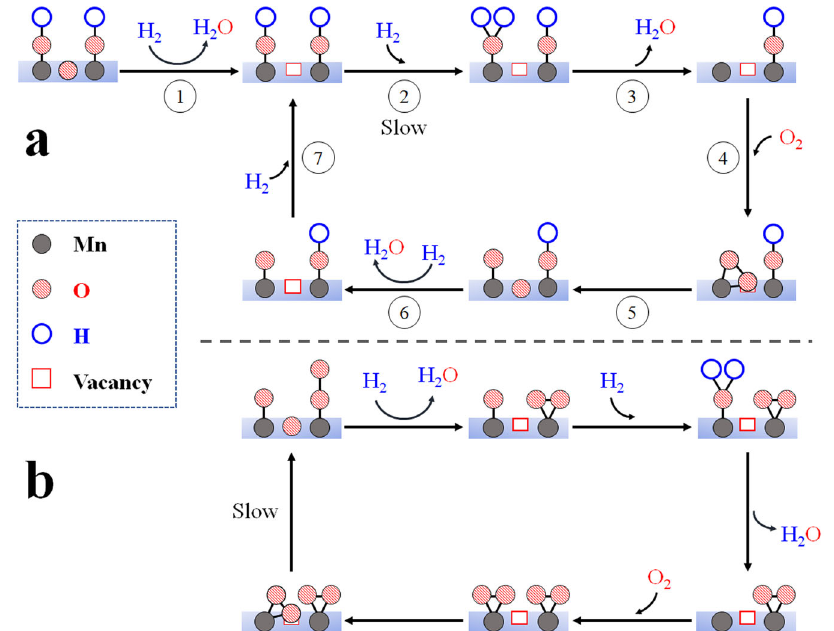
Fig. 6 Roles and mechanisms of surface oxygen species and OVs in H 2 oxidation at β -MnO 2 surfaces. a H 2 oxidation between 110 and 150 °C . b H 2 oxidation at a temperature higher than 150